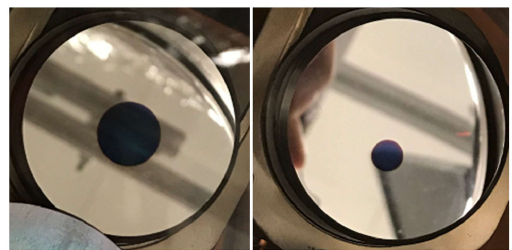
FIG. 2. LEReC cathode pucks with deposited cathode material. Left: Active cathode area of 12 mm diameter in the center used during the gun commissioning in 2017. Right: Active cathode area of 6 mm diameter shifted by 4 mm from the center used during LEReC high-current operation in 2018 and 2019.